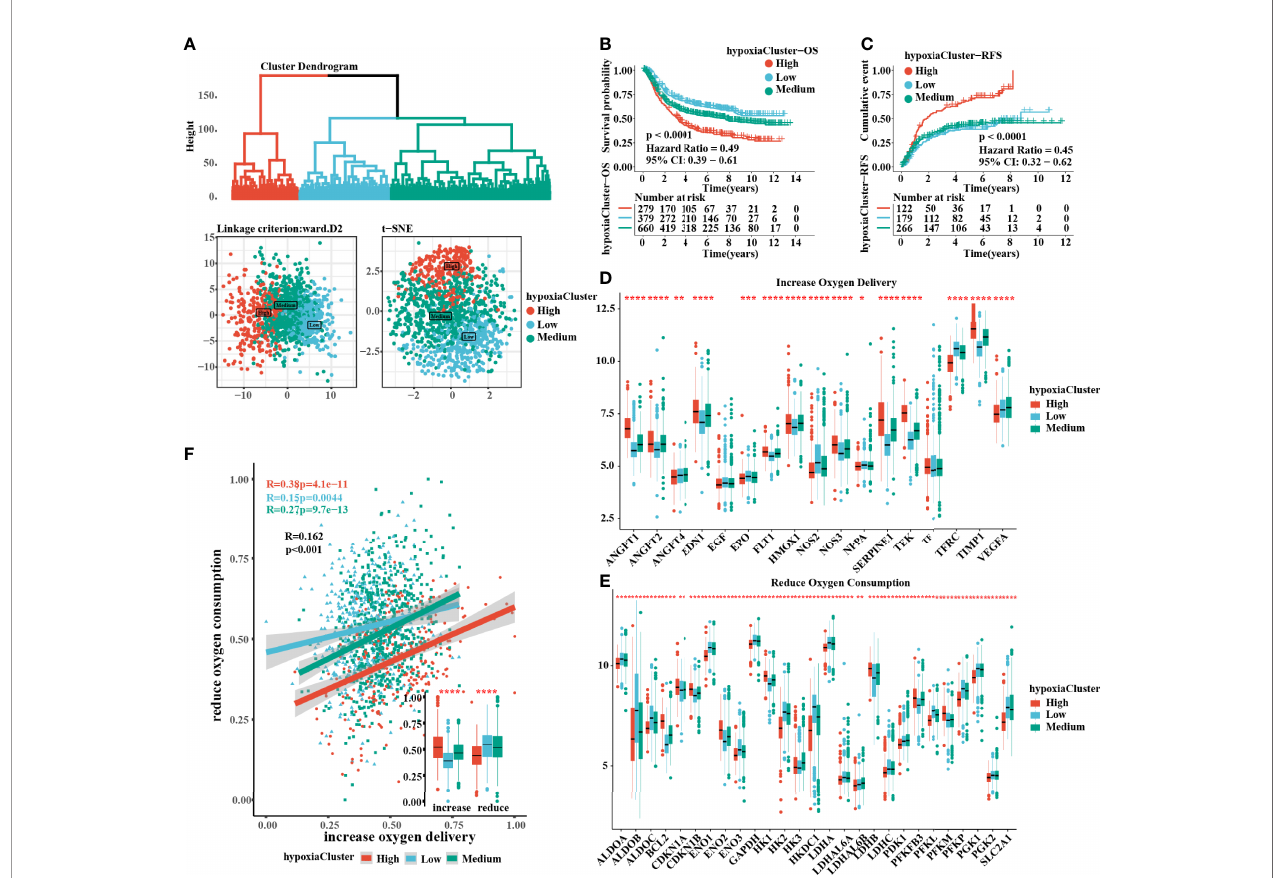
FIGURE 2 | Three hypoxia types with distinct prognosis characteristic and oxygen transport status. (A) Identi fi cation of hypoxiaClusters by unsupervised hierarchical clustering analysis. PCA and t-SNE analysis supported to divide patients into 3 hypoxiaClusters. (B, C) Kaplan – Meier curves were plotted to demonstrate the difference of prognosis by OS and RFS. (D, E) The oxygen transport status between different hypoxiaClusters was analyzed through increasing oxygen delivery and reducing oxygen consumption target genes and correlation. The lines in the boxes represented the median value. (F) Between the two groups, it was revealed that cluster high had the highest increase in oxygen delivery but the lowest reduction in oxygen consumption, while the cluster low had the opposite. PCA, principal component analysis; t-SNE, t-distributed stochastic neighbor embedding; OS, overall survival; RFS, recurrence-free survival. The asterisks represented the statistical p-value (*P <0.05; **P< 0.01; ***P< 0.001; ****p < 0.0001). The Kruskal – Wallis test was used to compare the statistical difference between three gene